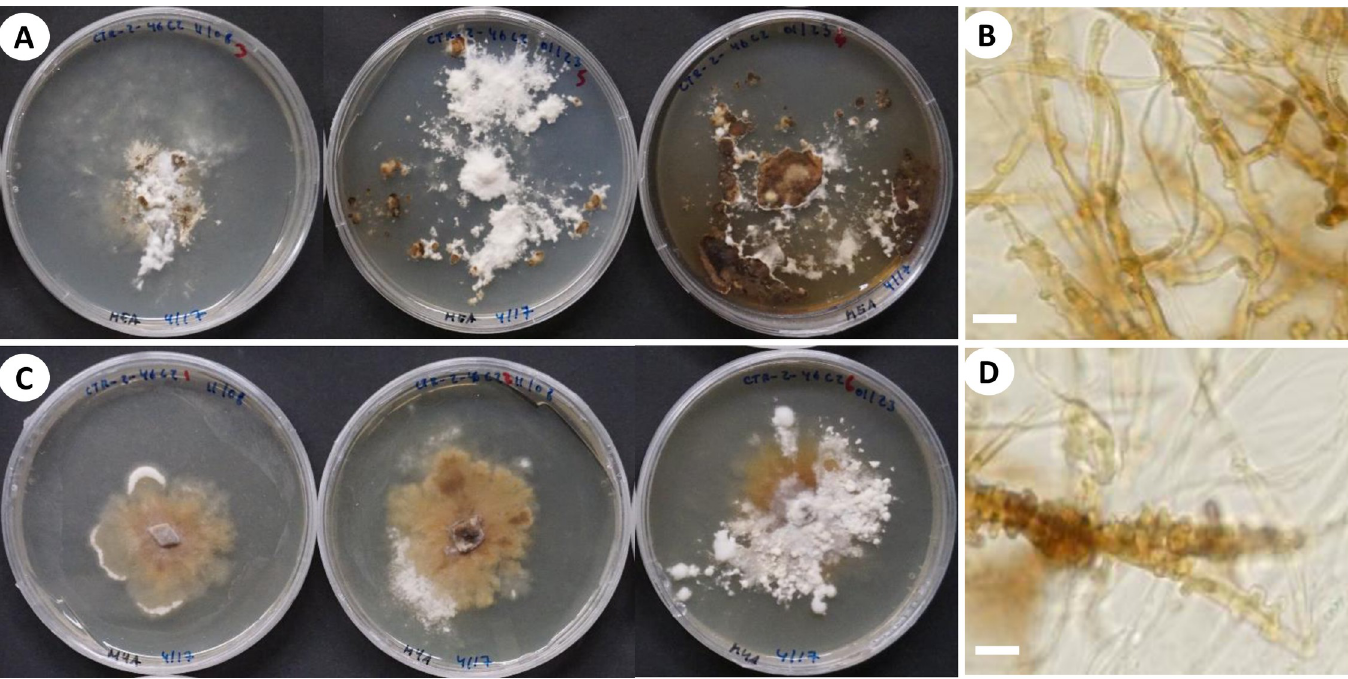
Fig 4. Cultural characteristics and microscopic features of A . yasuniensis . A. macromorphology of colonies on MEA. B. Highly branched hyphae with simple septa and clamp connections. C. Macromorphology of colonies on MYA. D. Generative hyphae with numerous round-like swellings. B and D stained with Melzer’s reagent. Scales bars = 10 μ